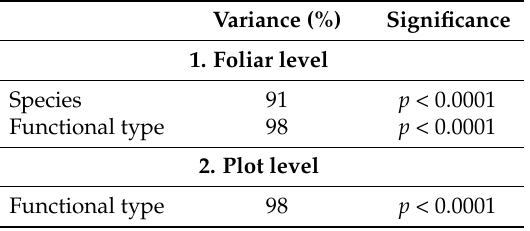
Table 3. Amount of variance explained by species and functional types in nitrogen at the foliar level ( n = 61) and plot level ( n = 26).